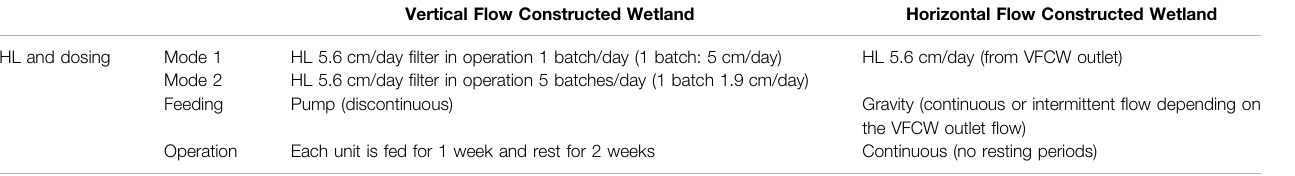
TABLE 2 | Operation parameters of the hybrid Constructed Wetland. Vertical Flow Constructed Wetland Horizontal Flow Constructed Wetland HL and